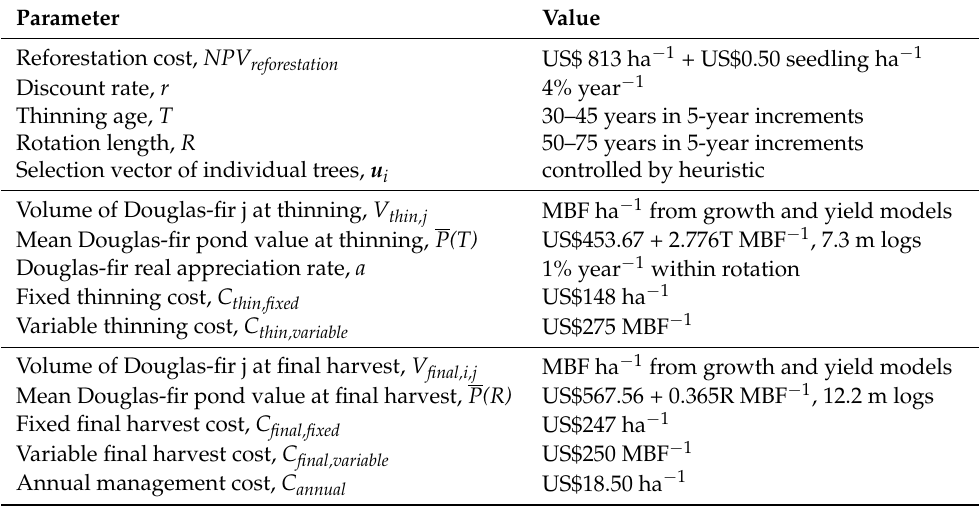
Table 2. Economic parameters used in calculating per hectare land expectation value (LEV). Timber